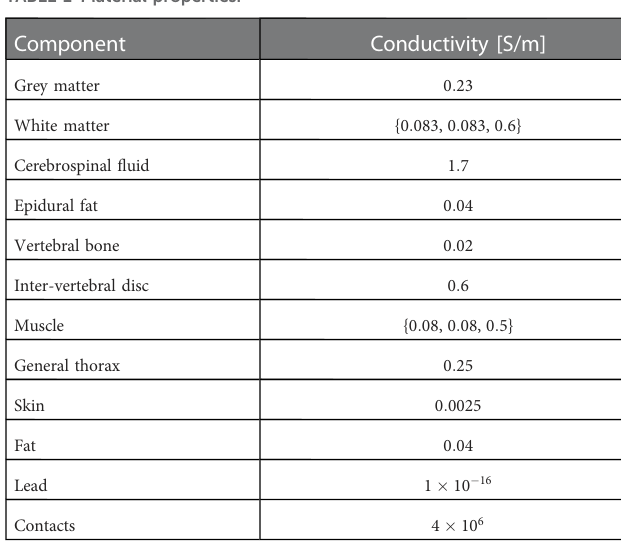
TABLE 1 Material